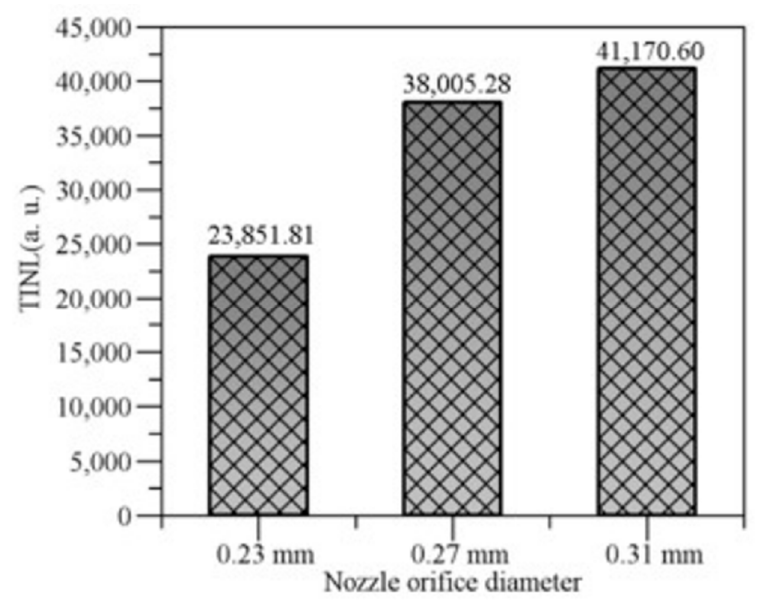
Figure 17. Flame time integral natural luminosity (TINL).